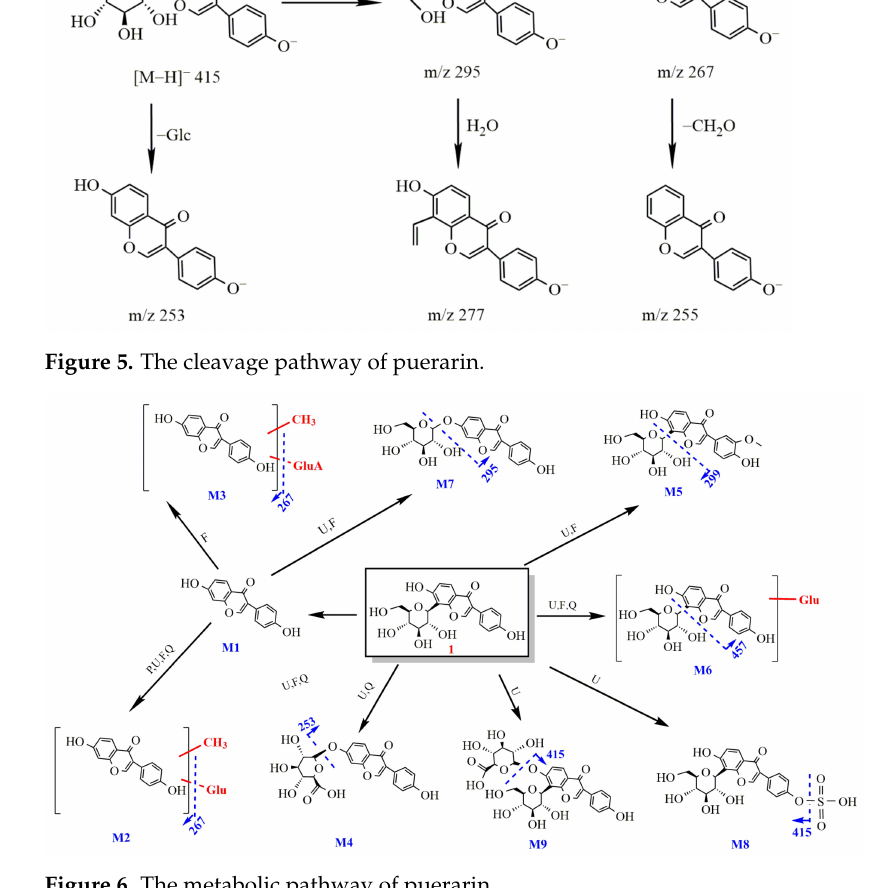
Figure 6. The metabolic pathway of puerarin.